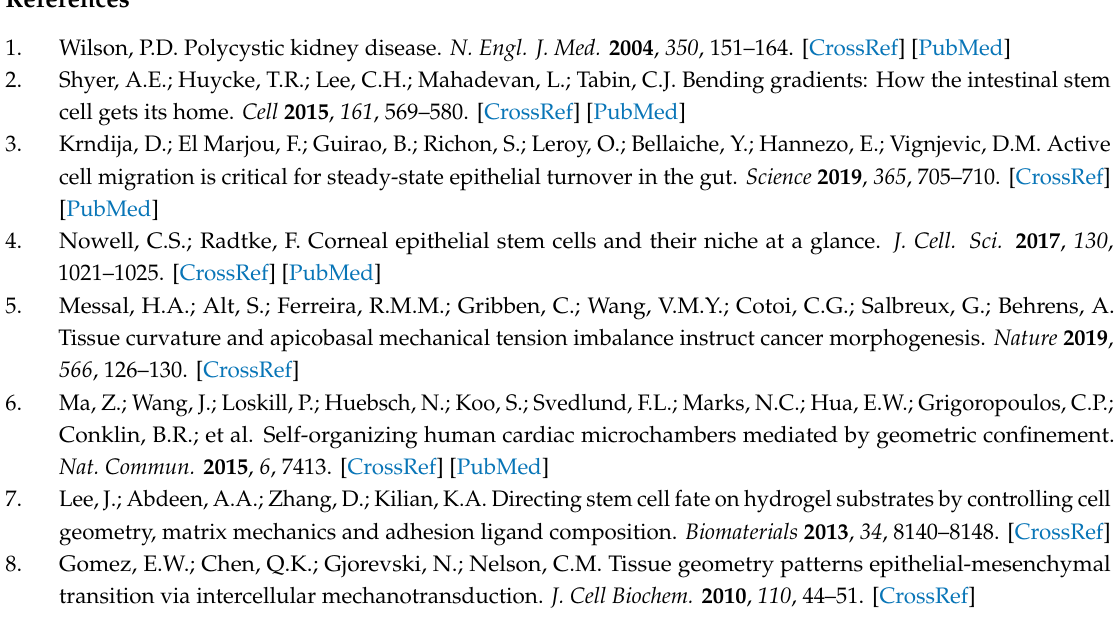
Figure S6: Morphology of MDCK cells on arm of triangle and square shape structure with CN03 and Lat-A treatments, Figure S7: Morphology of MDCK cells on the corner of triangle, square, and circle shape structure with CN03 treatment, Figure S8: The expression of vimentin, keratin intermediate filaments and α -tubulin on arm of triangle and square structure, Figure S9: Area of epithelial cells on convex geometric structure with a various shape at 4 days of cell